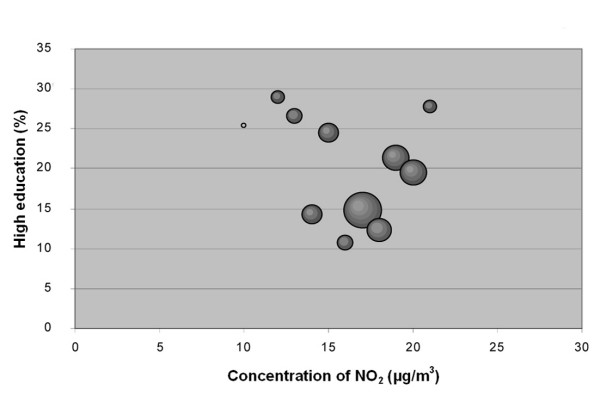
Bubble diagram for Malmö; Percentage of population in Malmö with high education versus annual mean concentration of NO2 at their real estate. The bubbles are sized according to the weight of the estimate, which depends on the size of the population that the estimate is based on. The weight is thus a measure of the uncertainty in the estimate, and large bubbles represent more certain and influential estimates than small bubbles.